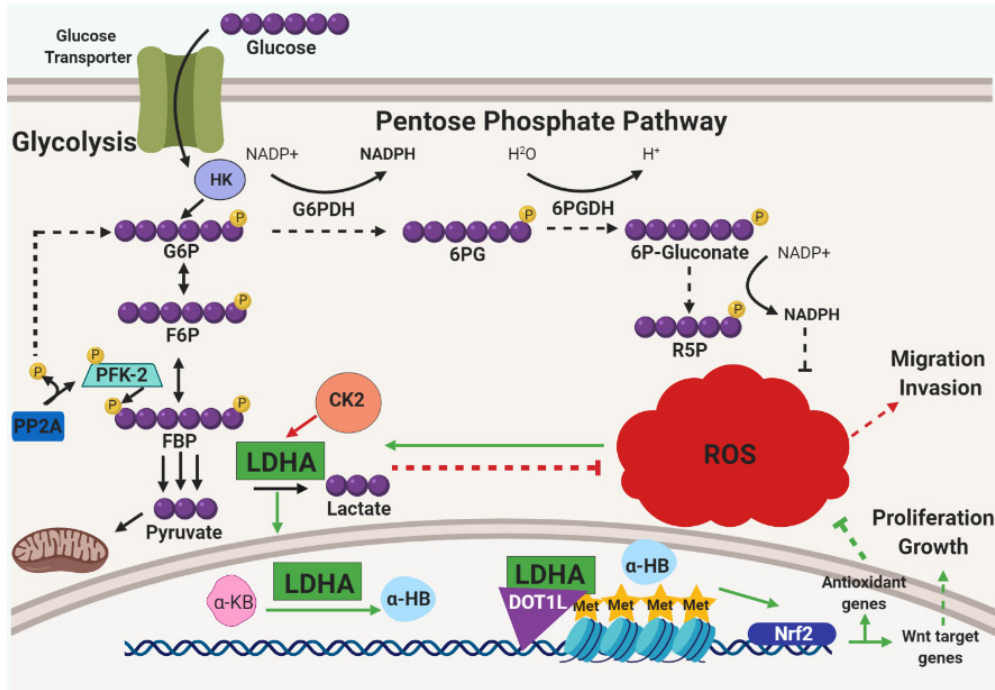
Figure 3. Glucose metabolism is highly crucial for cancer cells. This six-carbon monosaccharide can not only be used to fuel the energetic needs of cancer cells, but also to address the oxidative stress that accumulates as a byproduct of proliferation, metabolism, and growth. One mechanism employed to address oxidative stress is the use of the serine/threonine-protein phosphatase 2A (PP2A). During glycolysis, 6-phosphofructo-2-kinase (PFK-2) drives the commitment of glucose flux through the glycolytic pathway by influencing the phosphorylation of fructose-6-phosphate (F6P) and converting it into fructose-1,6,-bisphosphate (FBP). PP2A can reverse the flux of glucose to flow into the pentose phosphate pathway (PPP) by de-phosphorylating PFK-2. When this occurs, an increase of NADPH is generated and subsequent decreases in ROS is observed. The mechanism in this pathway is denoted by solid, black arrows, while the consequences of de-phosphorylated PFK-2 are marked by dashed, black arrows. Along the same note of rewired metabolism to address ROS accumulation, constitutive activation of casein kinase 2 (CK2) has been observed in many cancers, yet its mechanism was poorly understood. Recently, it was found that CK2 activity is dependent upon glucose metabolism, and from glycolysis, CK2 signaling relies on the metabolic enzyme lactase dehydrogenase (LDHA) to promote cancer cell migration and invasion. The CK2 / LDHA signaling pathway is marked by solid, red arrows and the results of this signaling is marked by dashed, red arrows. Intriguingly, although LDHA promotes the conversion of pyruvate into lactate at the end of glycolysis in the cytosol, oxidative stress induces its translocation to the nucleus wherein it promotes the conversion of α -ketobutyrate ( α -KB) into α -hydroxybutyrate ( α -HB) which promotes a complex formation with LDHA and disruptor of telomeric silencing 1-like (DOTL1) to drive a Nrf2-dependent transcription of antioxidant genes as well as Wnt target genes. The consequence of these upregulated genes is diminished ROS levels and promotion of tumor growth. The ROS-induced LDHA translocation pathway is marked by solid, green arrows, while the consequences are indicated with dashed, green arrows. Other Abbreviations: glucose-6-phosphate (G6P); hexokinase (HK); glucose-6-phosphate dehydrogenase (G6PDH); 6-phosphogluconolactone (6PG); 6-phosphogluconate (6P-Gluconate); ribose-5-phosphate